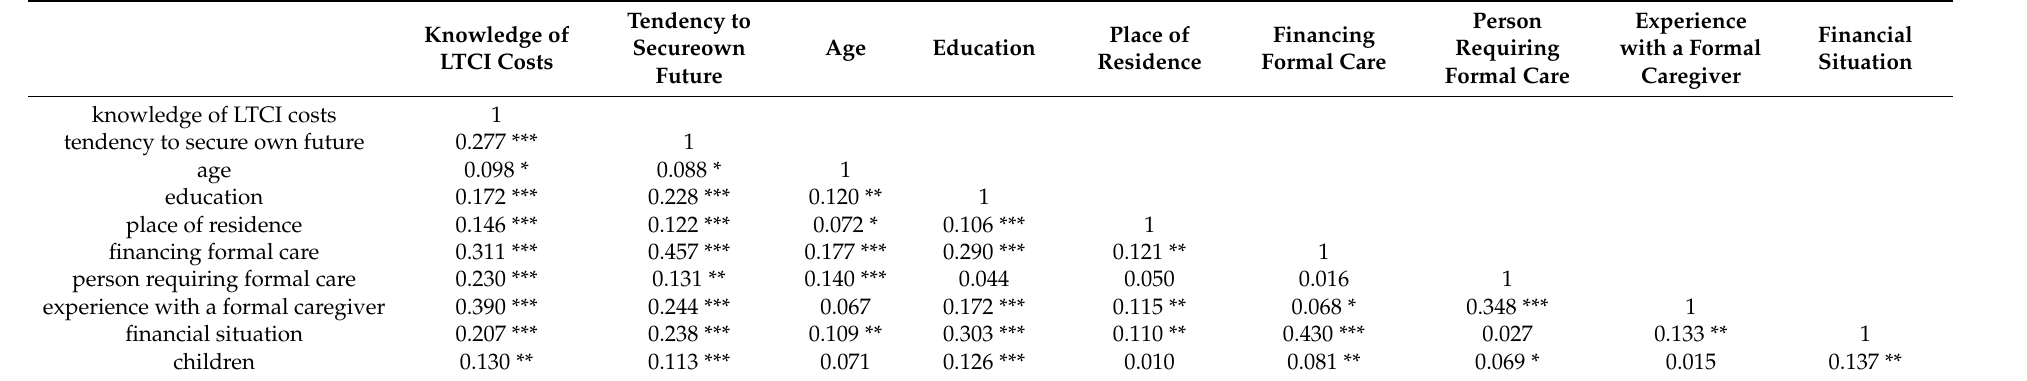
Table 5. The Cramer’s V coefficients correlation matrix for the selected